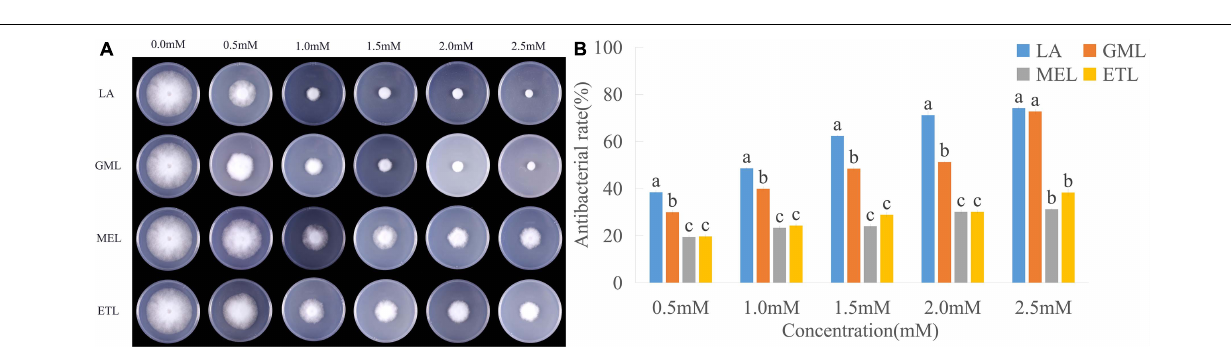
FIGURE 1 | Inhibitory effects of lauric acid (LA) to various P. sojae species. (A) Four different P. sojae races (Race2, Race7, Race17, and, Race19) were cultured on V8 medium with different concentrations of LA for 5 days. The experiment was repeated three times with similar results. (B) The diameter of each colony was measured and statistical analyzed via software Statistical Product and Service Solutions (SPSS). Means with different letters are significantly different ( p < 0.05).